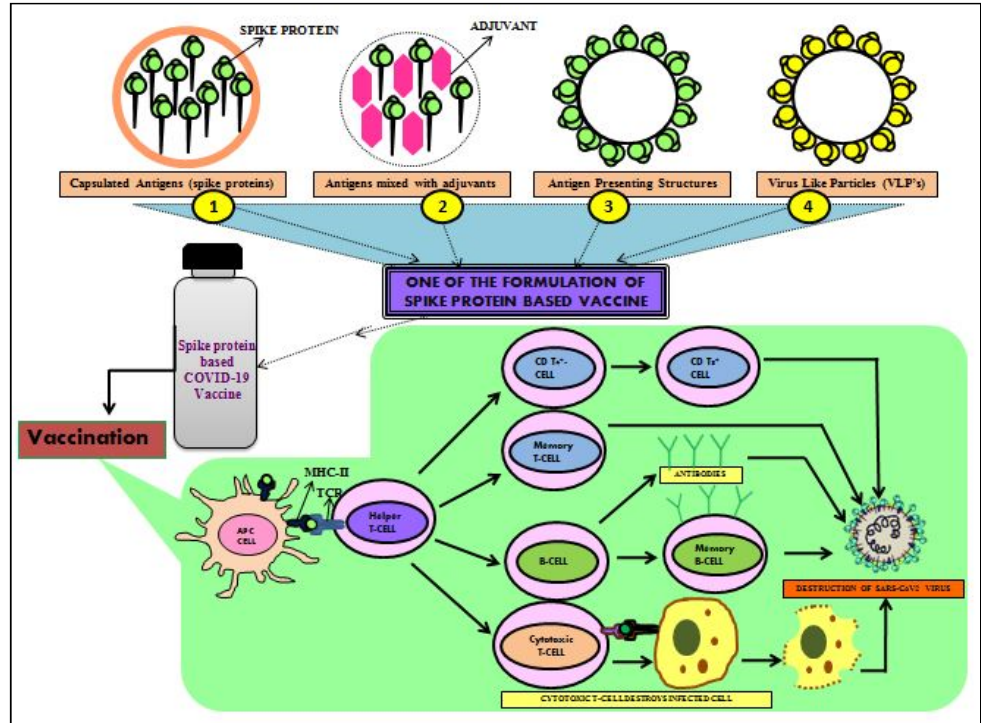
Figure 12. Mechanism of spike protein-based vaccines for developing immunity against COVID-19 infection: ( 1 ) spike proteins of the SARS-CoV-2 virus is enclosed inside a capsule; ( 2 ) spike proteins are mixed with adjuvants; ( 3 ) antigen-presenting structures are made with spike proteins; ( 4 ) virus-like particles are made with native spike proteins of the SARS-CoV-2 virus. The spike protein-based vaccines arecreated using one of the above four represented protein formulations. Upon vaccination with thespike protein-based vaccine, the antigen-presenting cells recognize the virus’s spike protein and present it to immune cells (i.e., Tcells and Bcells), resulting in both cell and antibody-mediated